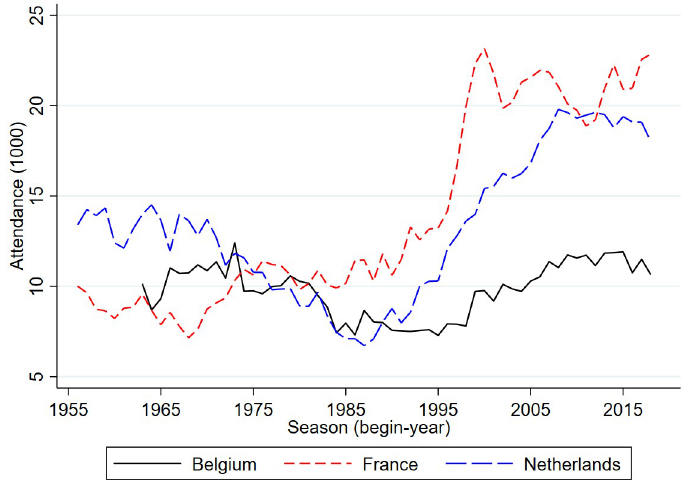
Fig 2. Stadium attendance professional football; Belgium, France, The Netherlands; 1956/57-2018/19 (1000).